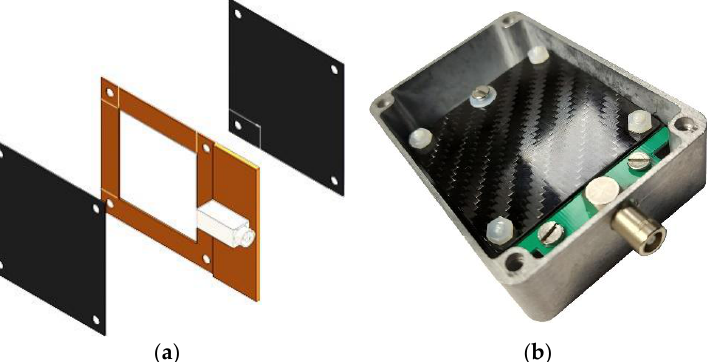
Figure 1. ( a ) The SiLiF detector arrangement as a double sided silicon diode sandwiched between two 6 LiF layers deposited on carbon fiber substrates; ( b ) a real detector assembled inside its aluminum box.